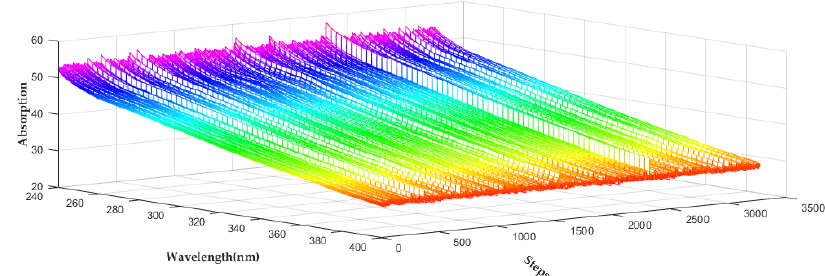
Figure 3. Original data of UV-Vis spectra of phenol.